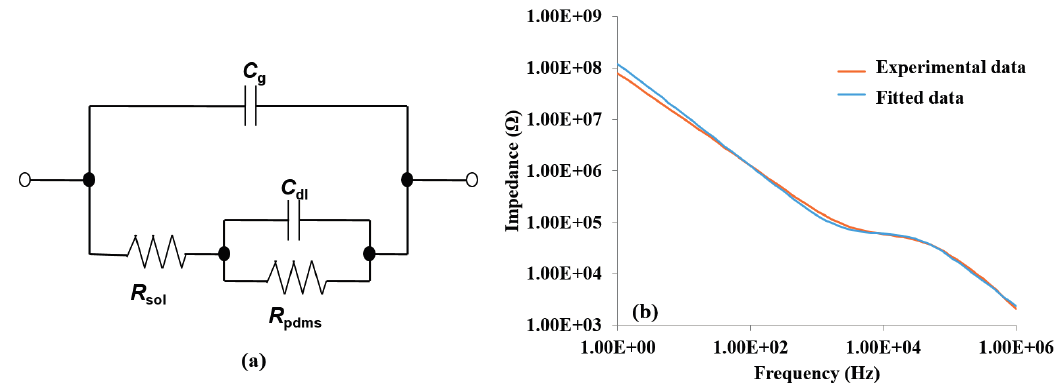
Figure 2. ( a ) The equivalent circuit used for data analysis. The equivalent circuit components were resistance of the solution ( R s ), resistance of PDMS ( R pdms ) , double layer capacitance ( C dl ), and geometrical capacitance ( C g ); ( b ) The bode diagram of measured impedance data and simulated impedance data generated by curve fitting of the equivalent circuit. The diagram data was measured by testing a H5N1 virus with a concentration of 12.8